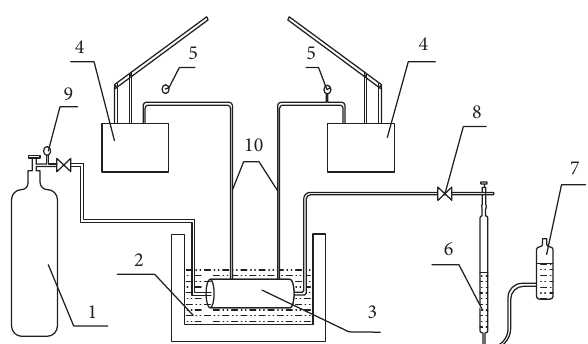
Figure 2: Schematic of the experimental system. 1, high-pressure gas cylinder; 2, thermostatic water bath; 3, triaxial osmoscope; 4, manual hydraulic pump; 5, oil pressure gauge; 6, burette; 7, levelling bottle; 8, valve; 9, reducing valve; 10, hydraulic tube.